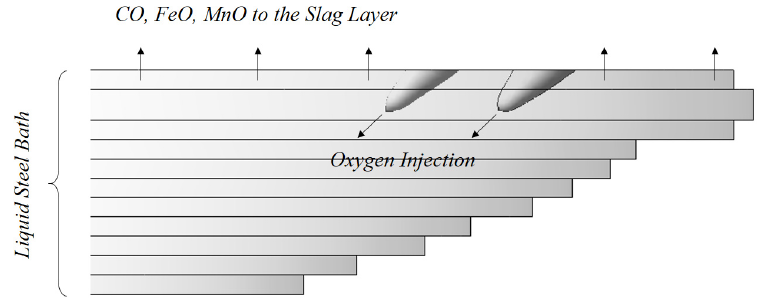
Figure 5. Oxygen injection through jet penetration cavities and absorption of oxides.